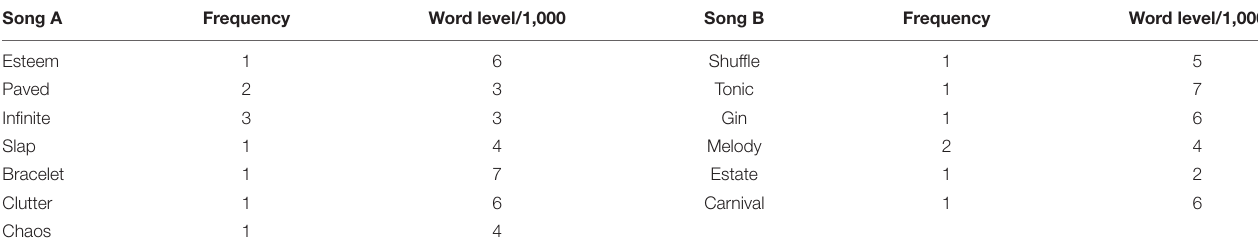
TABLE 3 | Frequency of occurrence, and word level of target